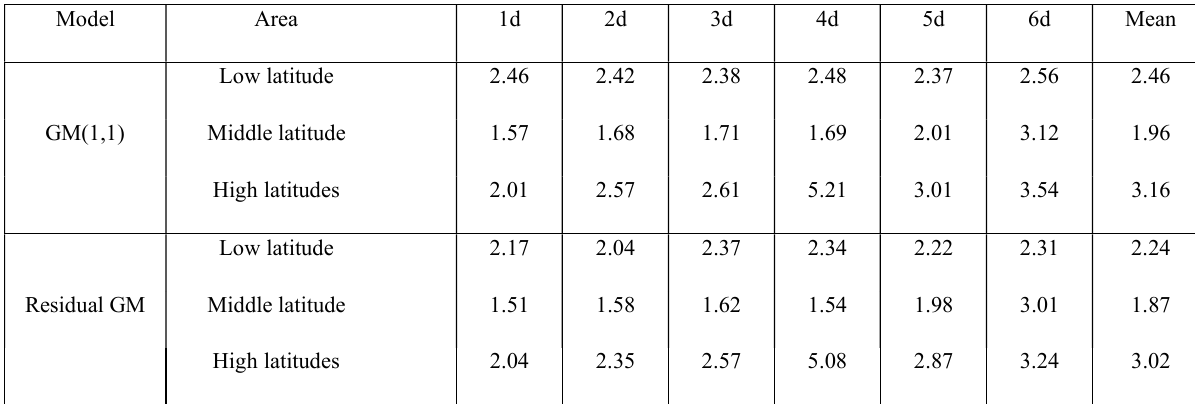
Table. 5 RMSE statistics of mean-variance in summer forecast